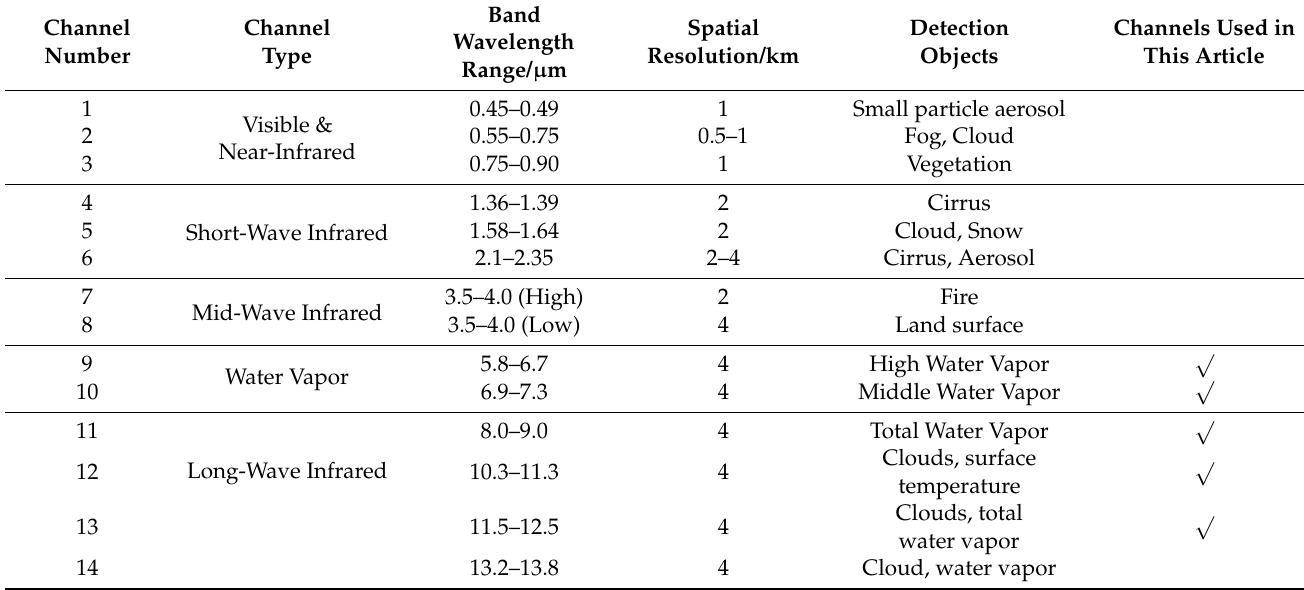
Table 1. FY-4A AGRI spectral band and main detection